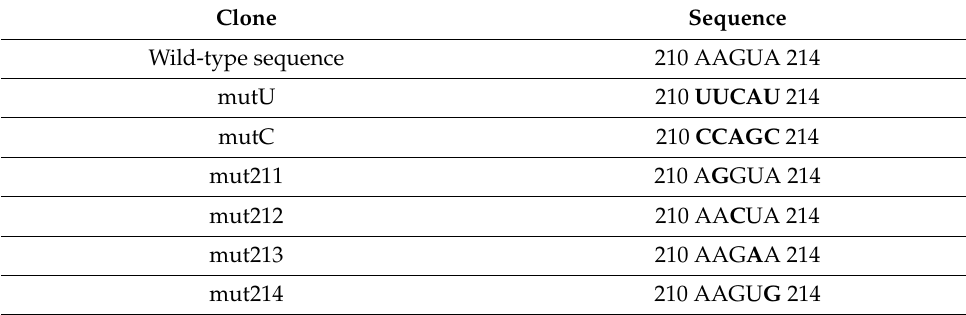
Table 2. Mutations in the HIV-1 IRES sequence to identify Unr binding site. Clone Sequence Wild-type